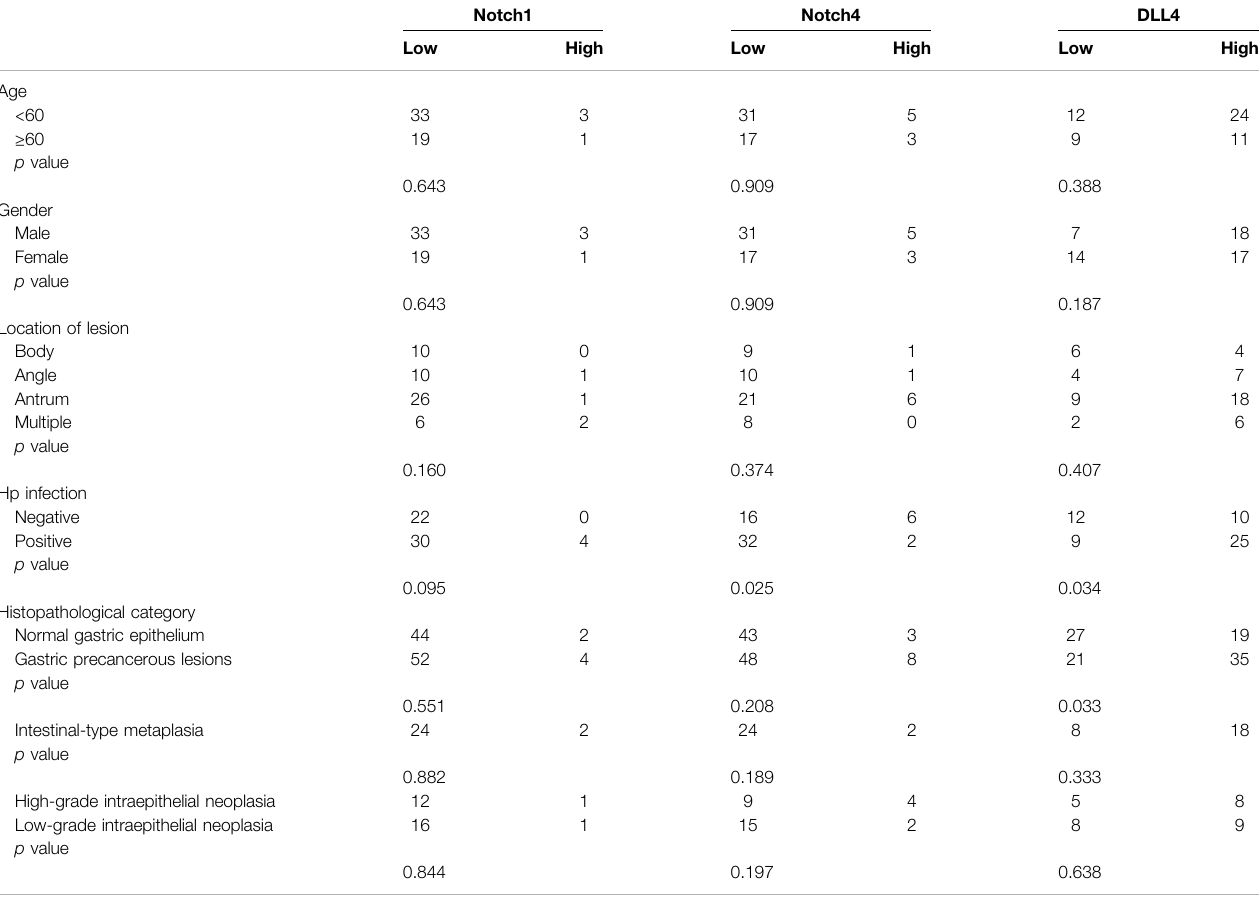
TABLE 2 | Correlation between DLL4 positivity and clinicopathological